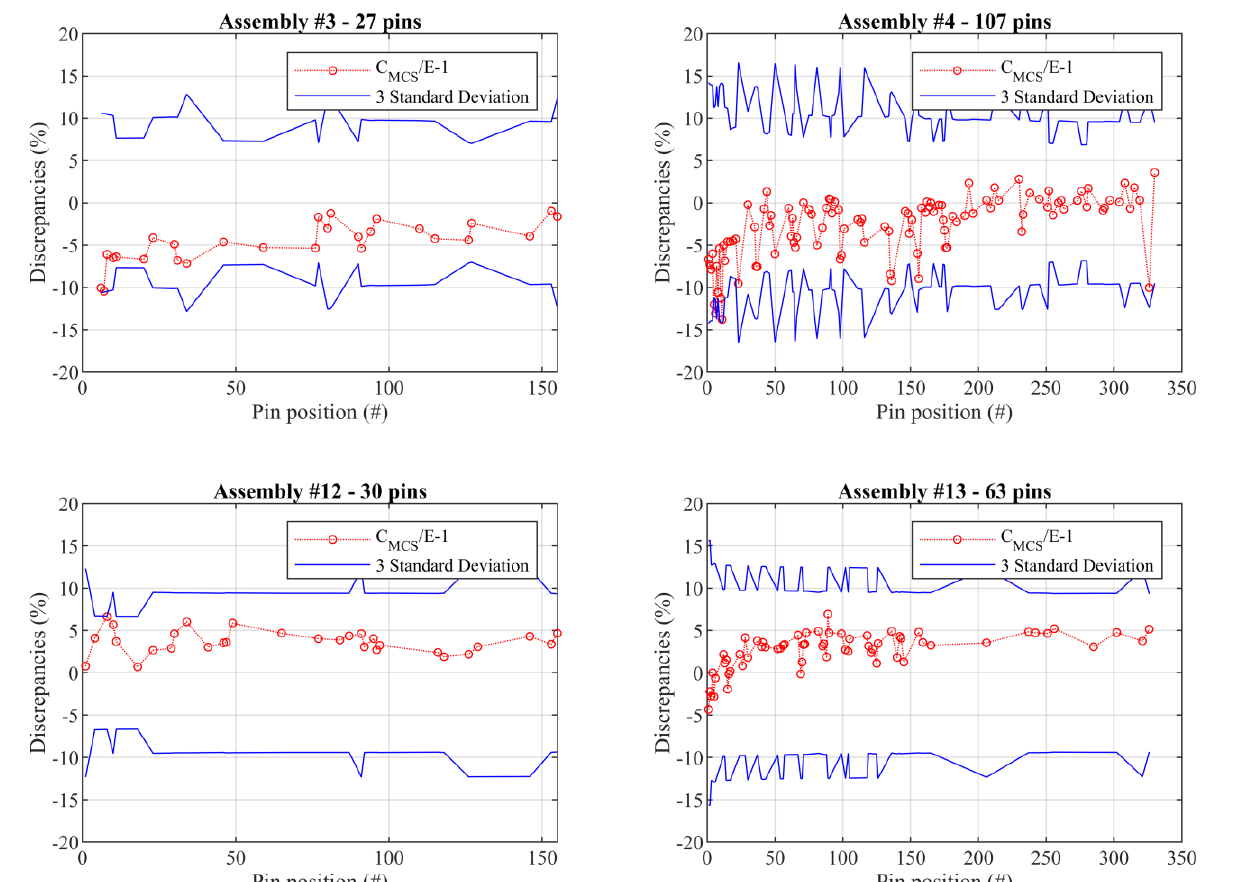
Figure 3. Pin power comparison (C/E – 1) between MCS calculations and measurements